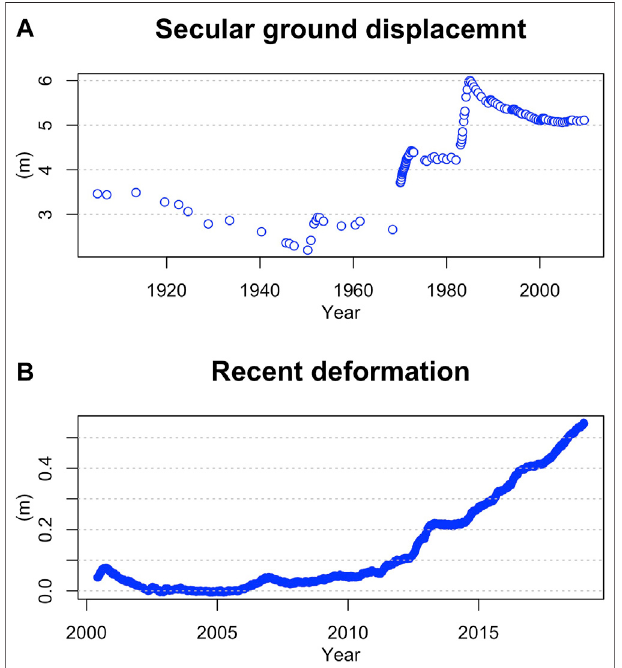
FIGURE 1 | (A) Secular ground displacement recorded at Pozzuoli harbour, after Del Gaudio et al. (2010); (B) Post-2000 ground deformation at the samelocation, based on GPSdata,after De Martino et al. (2014) and data from INGV – Osservatorio Vesuviano.